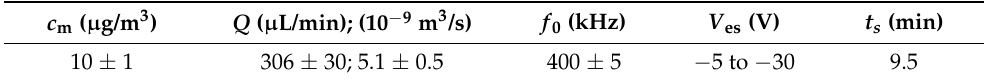
Table 3. Operating parameters of the PMC-µFC with carbon NPs ( c m : particle mass concentration; Q : air-flow rate; f 0 : cantilever resonance frequency; m 0 : cantilever mass; t s : sampling time).